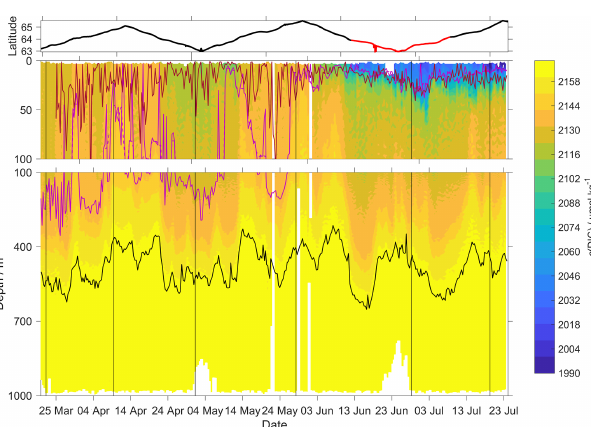
Figure 10. c (DIC) contour plot with z DCM (red line), z mix (pink line) five-point median z mix (dotted pink line). The black line in- dicates σ 0 = 1028kgm − 3 . The top panel indicates glider latitude (black: NwAC; red: